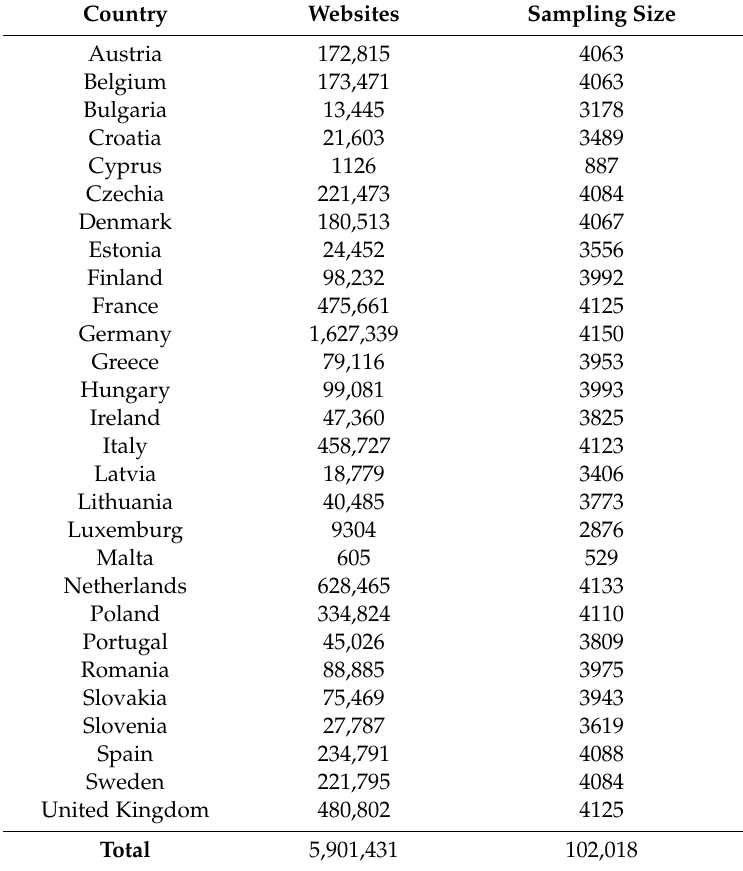
Table 2. Number of available websites and appropriate sampling size per country.